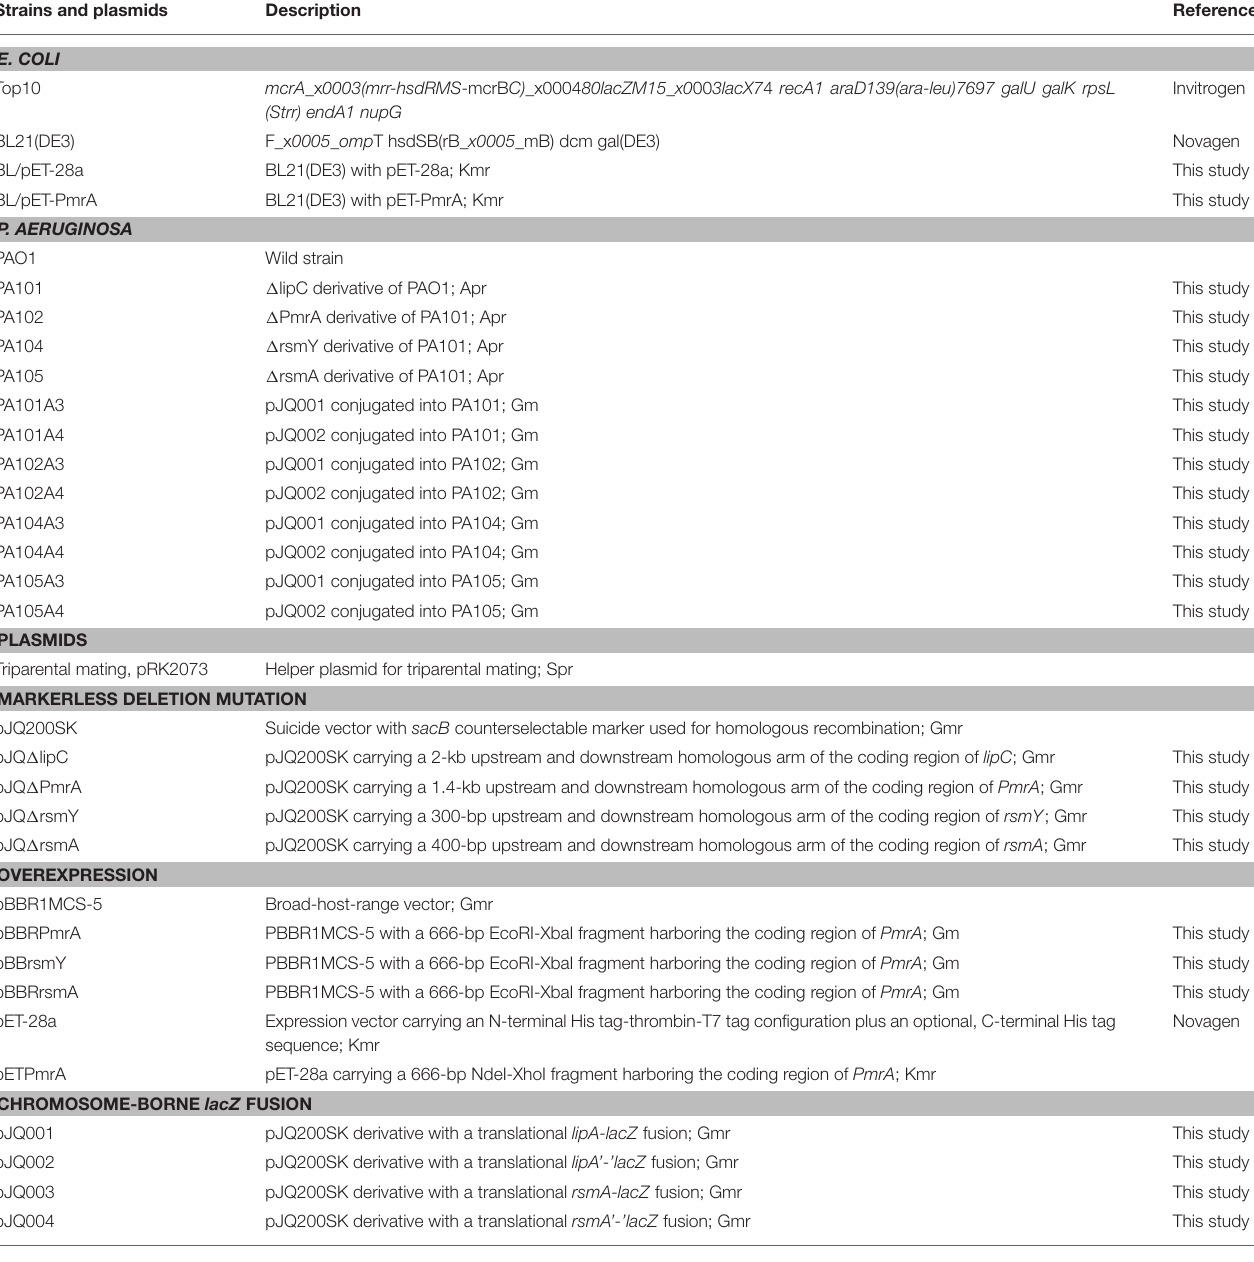
TABLE 1 | Strains and plasmids used in this